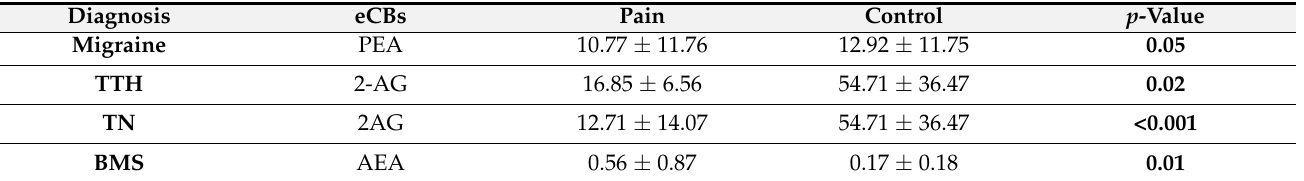
Table 2. Salivary eCB levels for migraine, TTH, TN, and BMS compared with the controls (mean ± SD; fmol/mg protein).